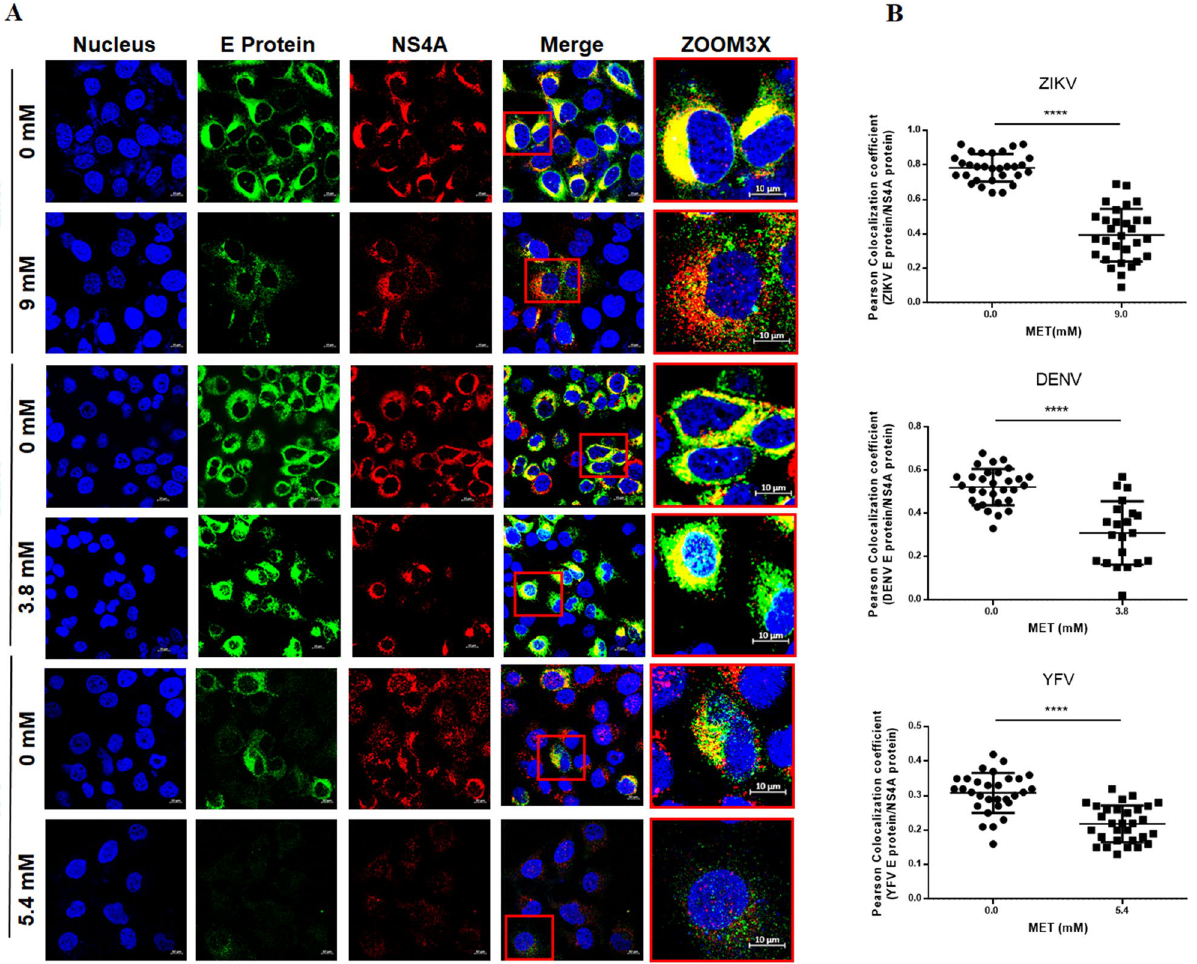
Figure 4. MET inhibits replicative complex formation during flavivirus infection. ( A ) The distribution of the E (green) and NS4A (red) viral proteins present at Flaviviruses-replication complexes was evaluated by